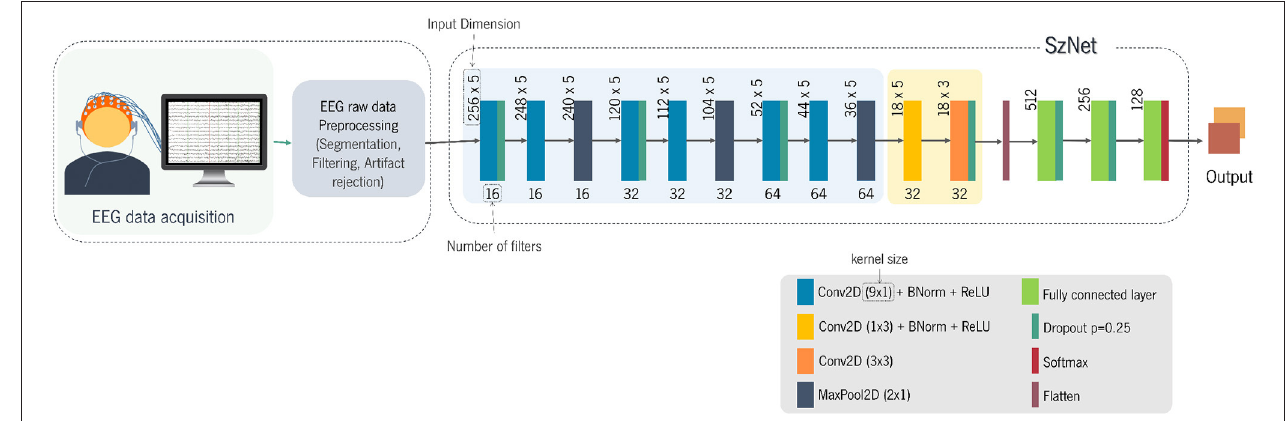
FIGURE 4 | Schematic illustration of the end-to-end process with the first block corresponding to EEG data acquisition and pre-processing. The second block shows the architecture of the SzNet model in